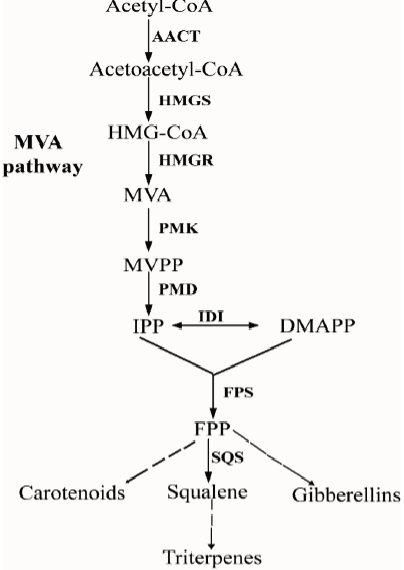
Figure 1. Main steps in the biosynthesis of terpenoids in fungi. The abbreviations used are: HMG-CoA: hydroxymethylglutaryl CoA; MVP: 5-phosphomevalonate;